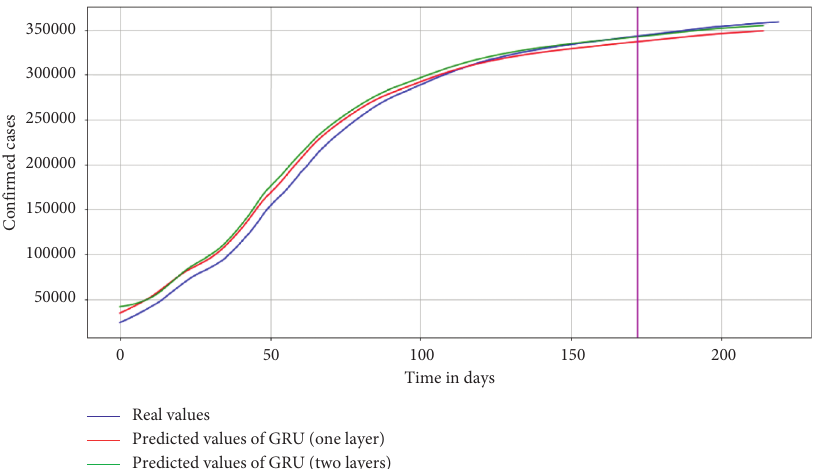
Figure 7: Comparison between real confirmed cases and the predicted confirmed cases for GRU (Saudi Arabia).